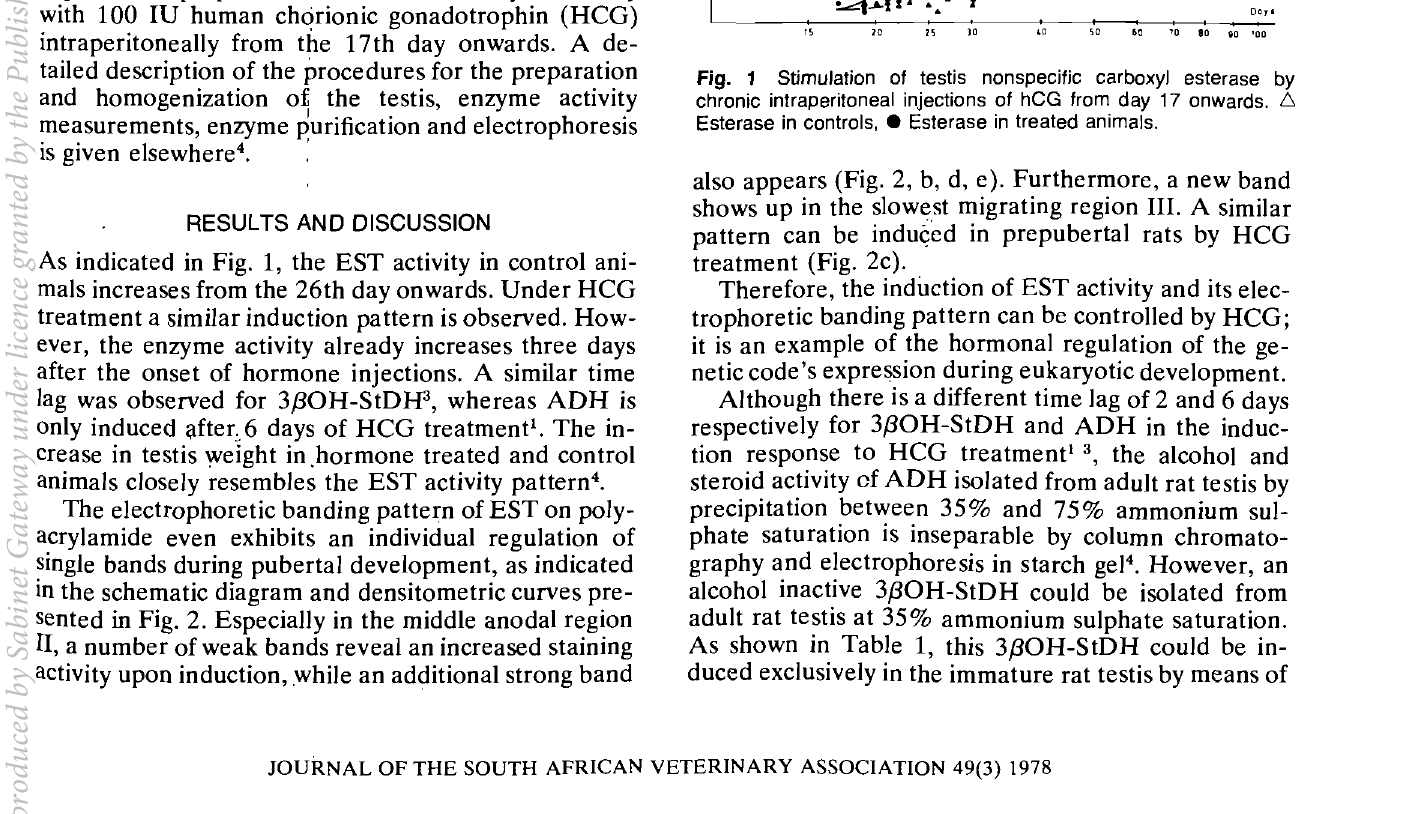
Fig. 1 Stimulation of testis nonspecific carboxyl esterase by chronic intraperitoneal injections of hCG from day 17 onwards. I:::, Esterase in controls, • Esterase in treated